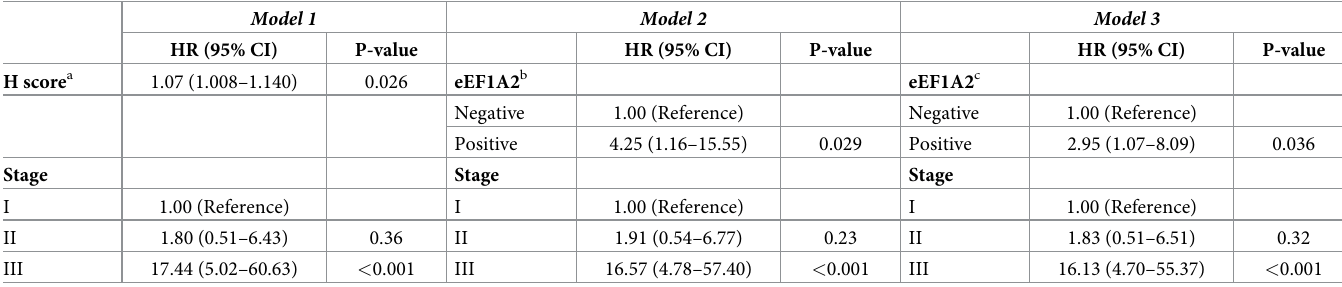
Table 6. Results from multivariate Cox models for